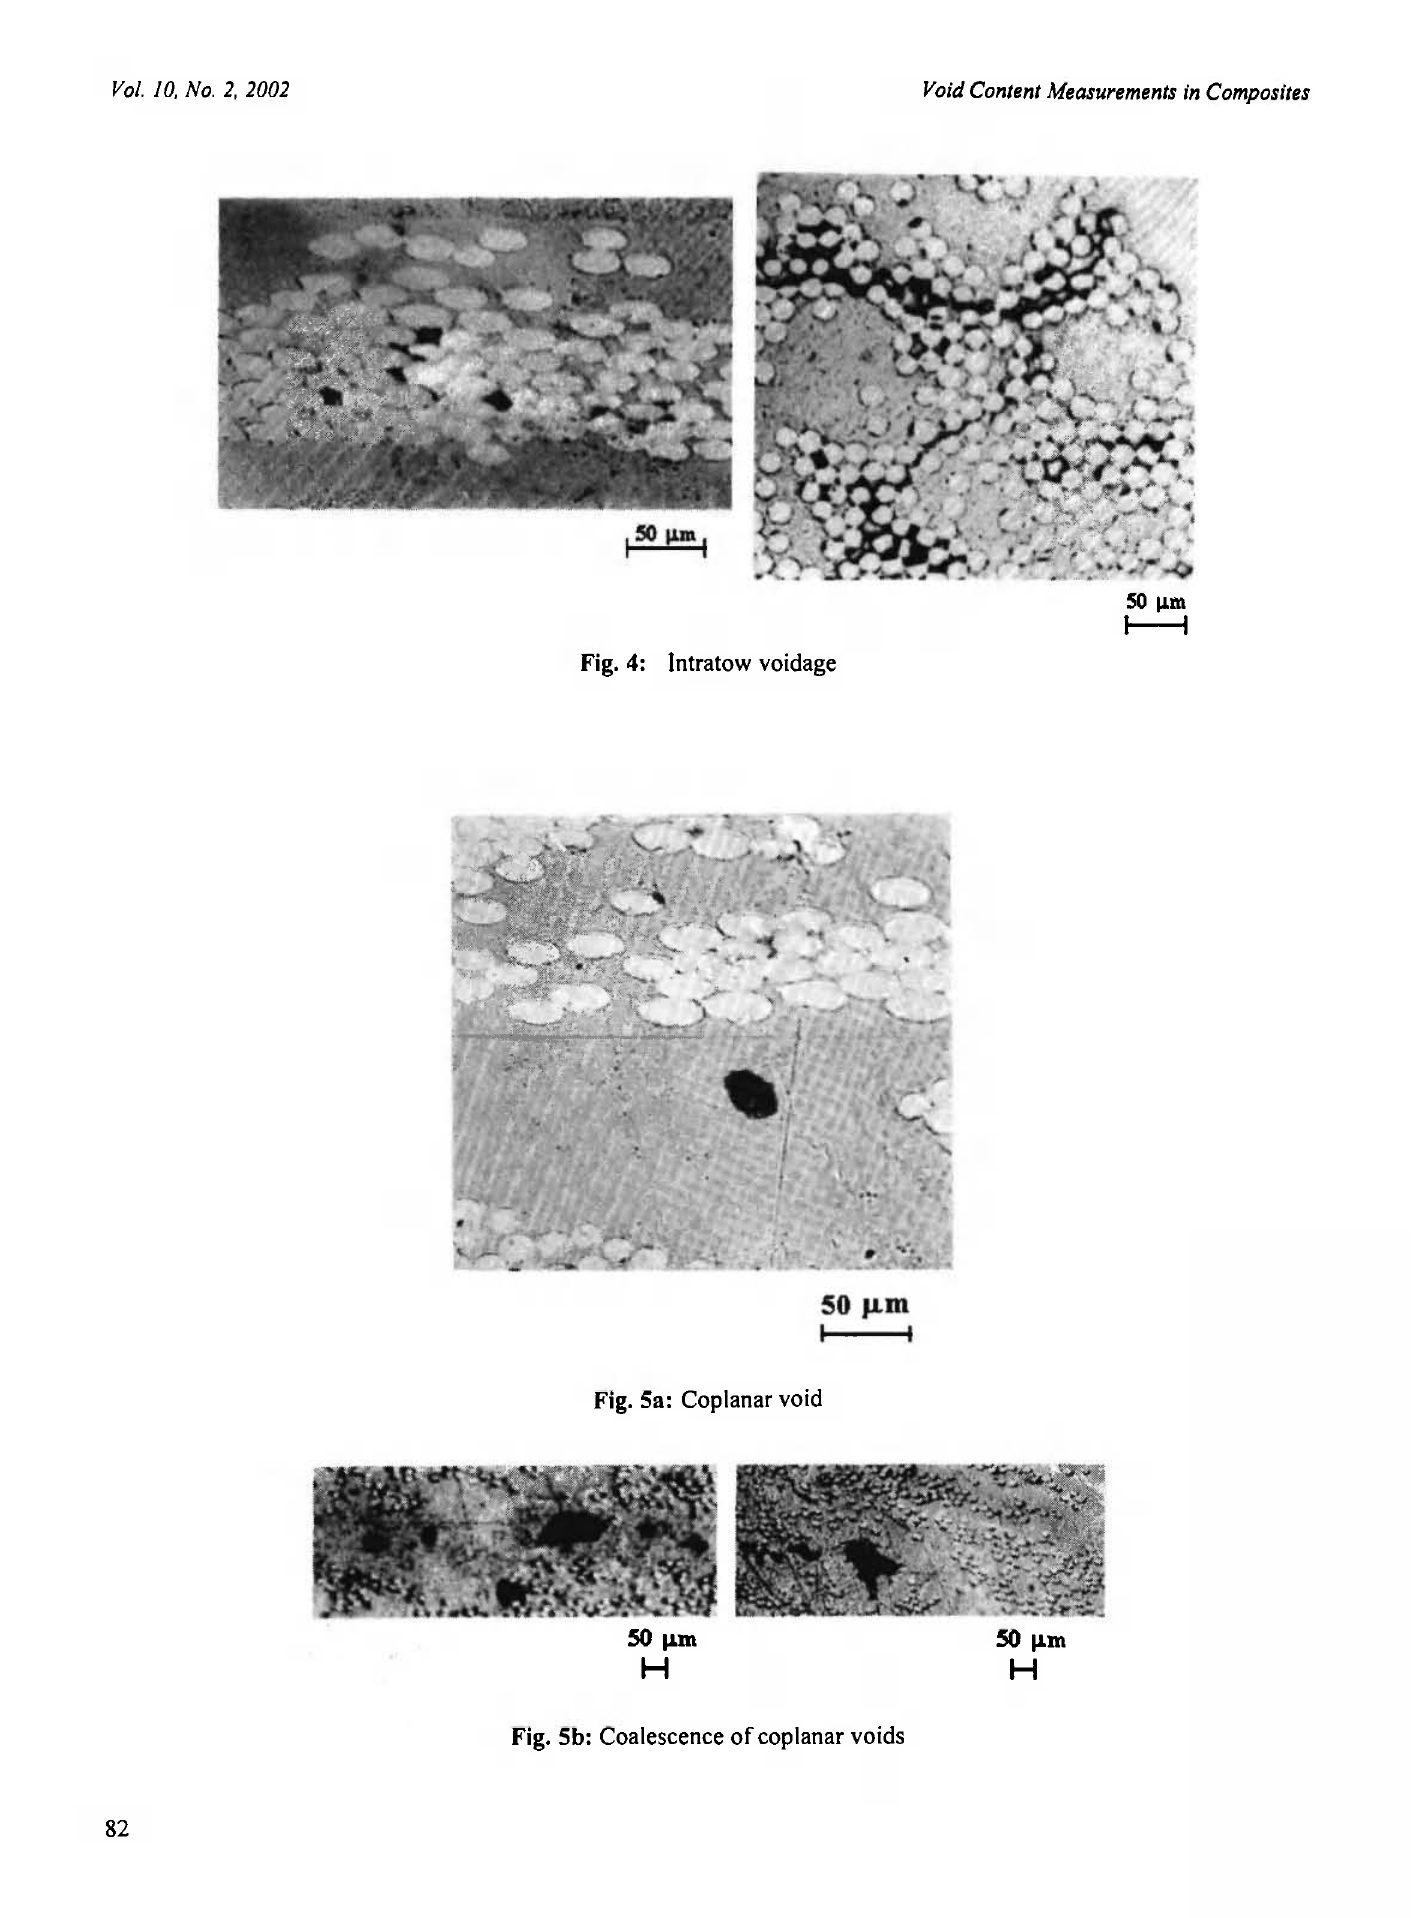
Fig. 5a: Coplanar void